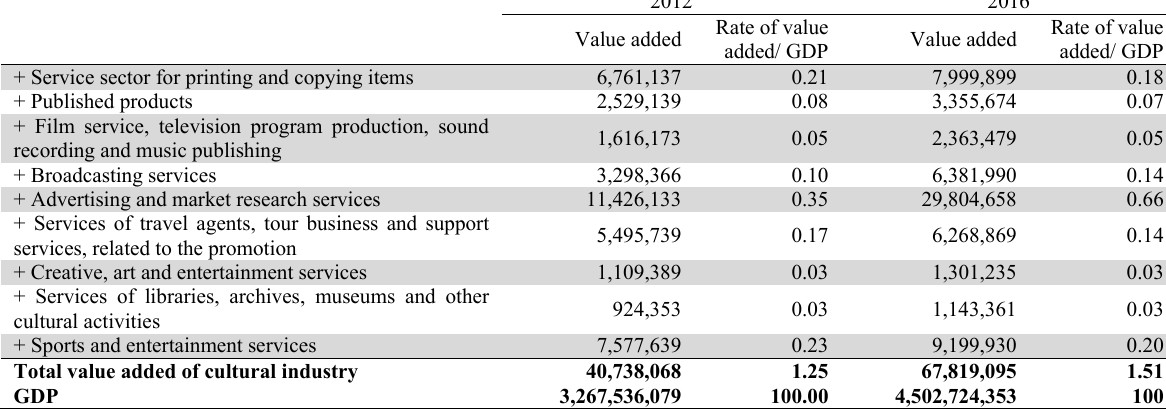
Value added of cultural industries in Vietnam ( Unit: million dong, % )